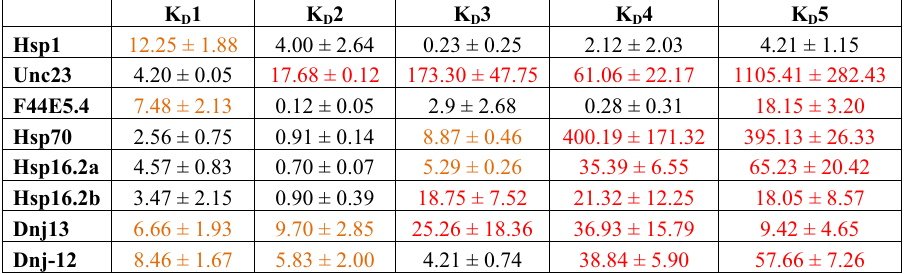
Table 8. Calculated K D values derived from SV-AUC fitting. No color coding = cooperativity, orange color coding = weak cooperativity, red color coding = no